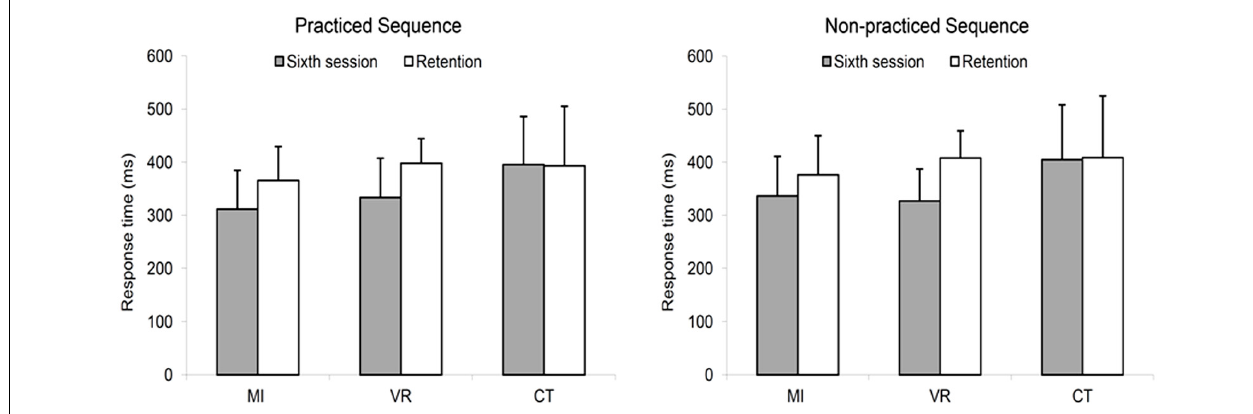
FIGURE 3 | Mean ( + SD) responses times for the practiced and non-practiced sequence, in each group, at sessions 6 and 7 (Retention). MI, Motor imagery group;VR, verbal rehearsal group; CT, control group.